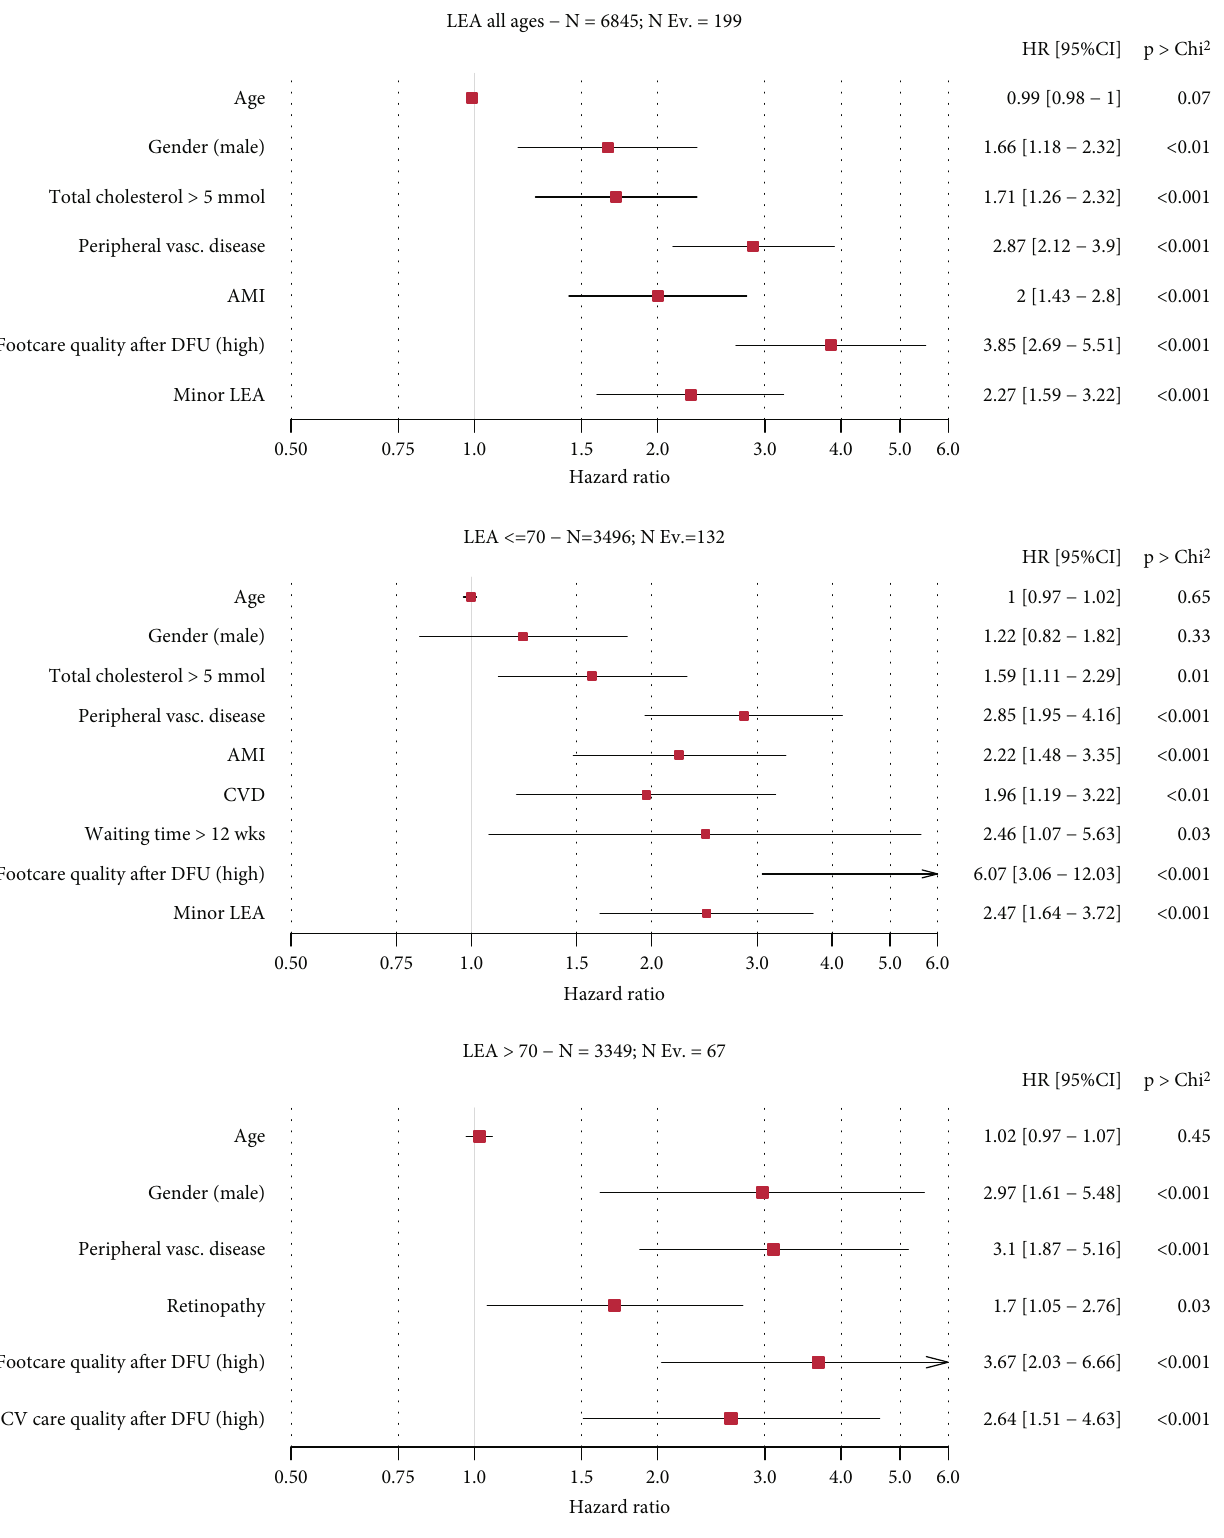
Figure 1: Multivariate analysis for LEA as an